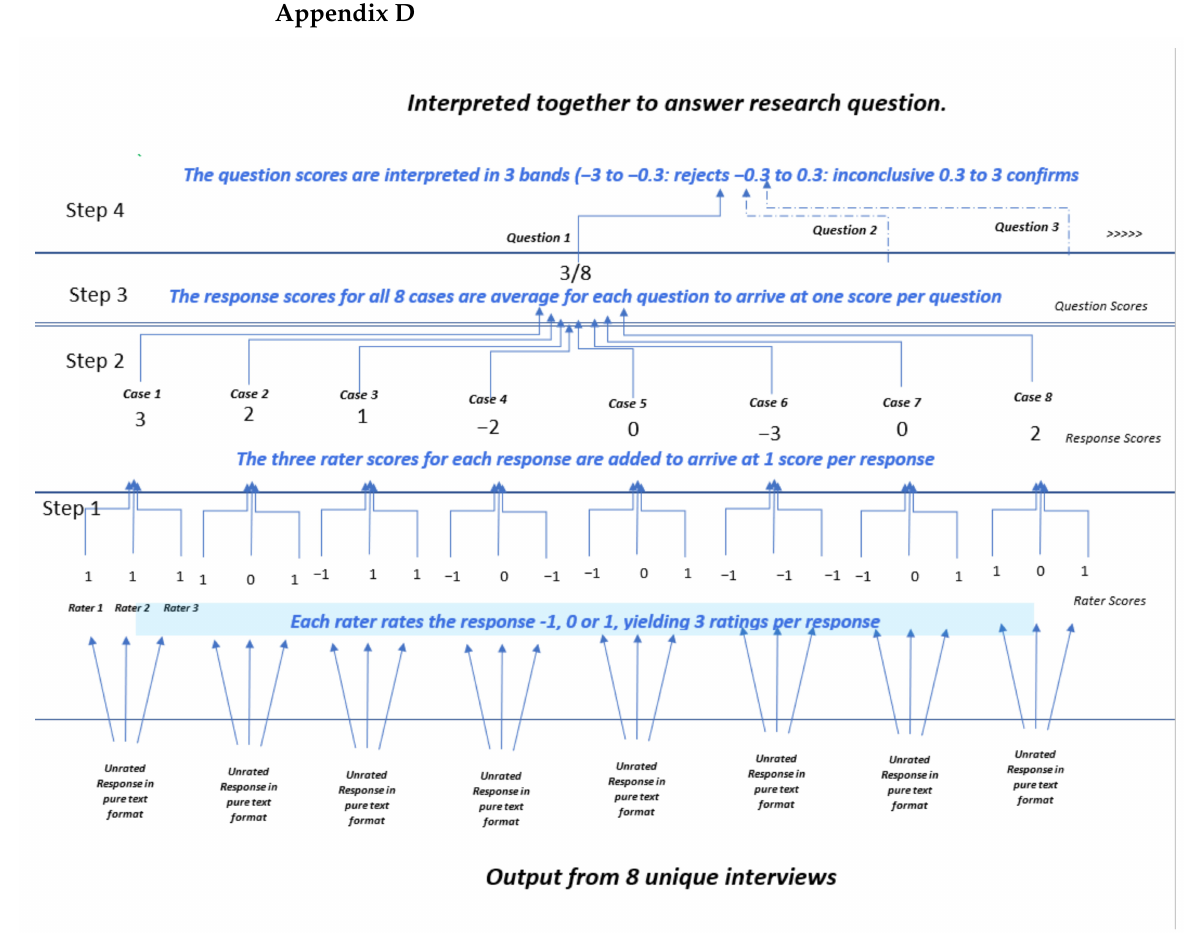
Figure A1. Four step scoring